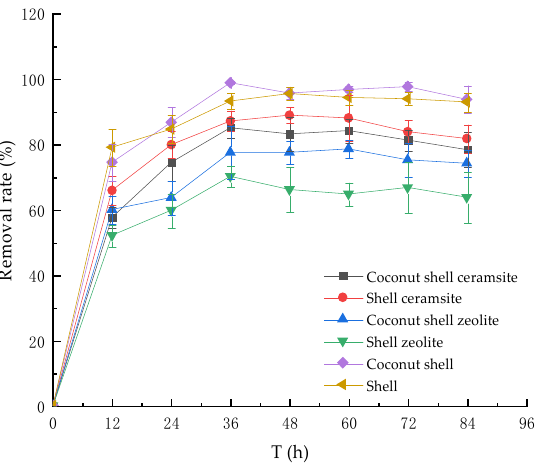
Figure 5. Removal effect of biochar-constructed wetland on total nitrogen.